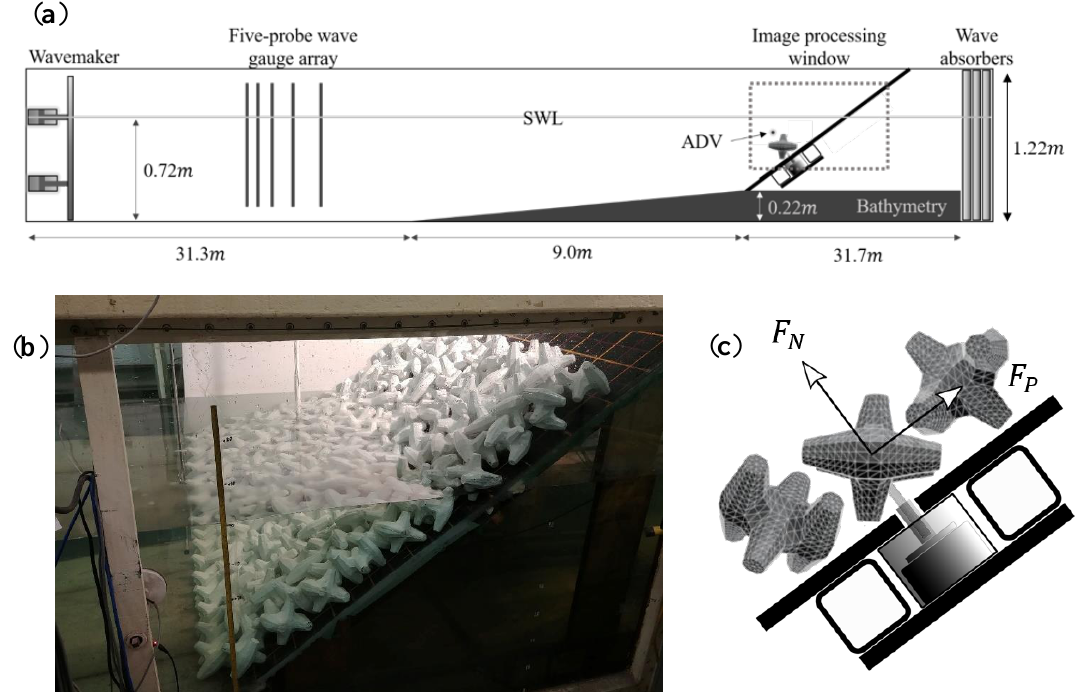
Figure 1. ( a ) Diagram of the model setup (not to scale); ( b ) photograph of the model structure; and ( c ) schematic of the armor unit-force sensor coupling mechanism.